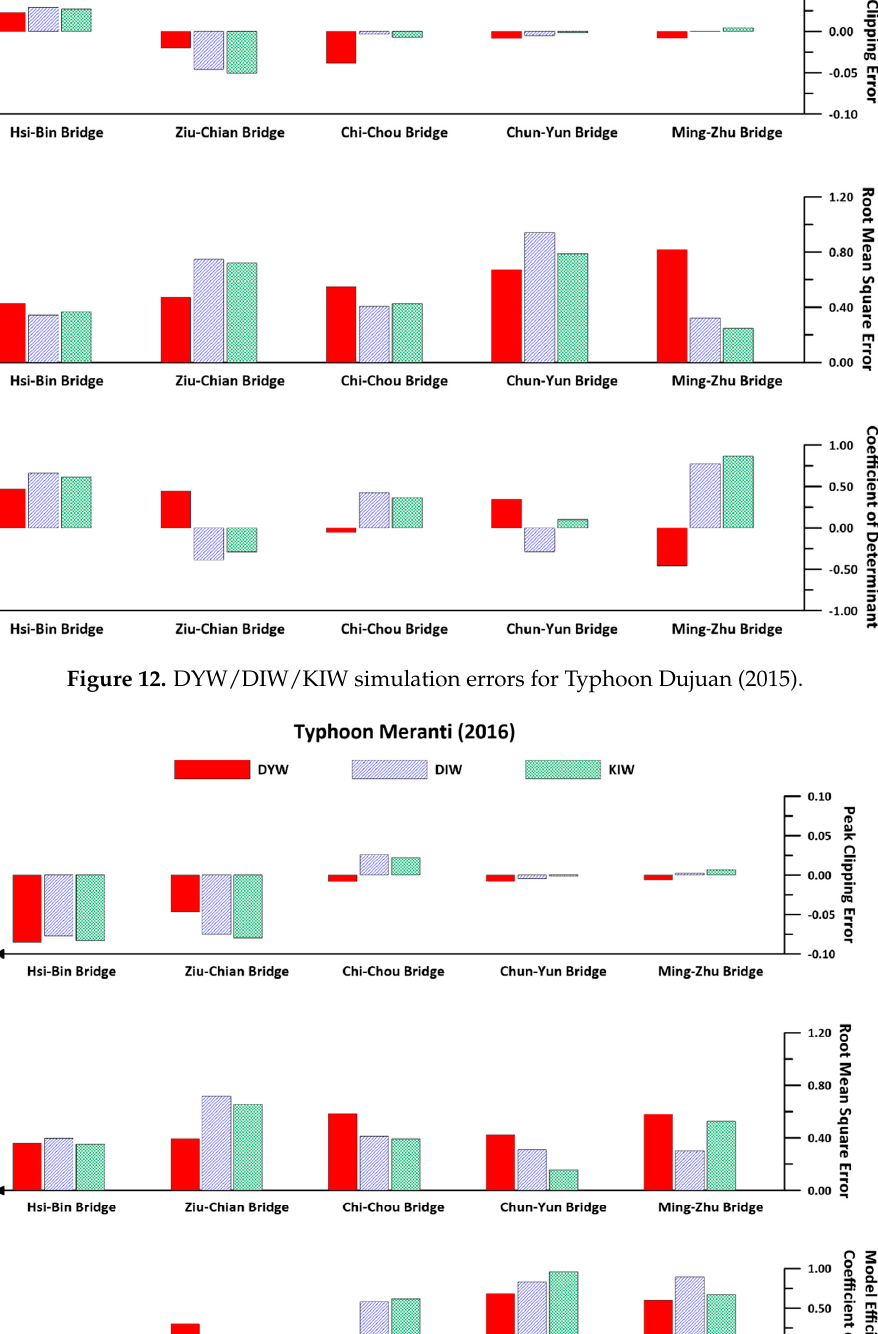
Figure 13. DYW/DIW/KIW simulation errors for Typhoon Meranti (2016).